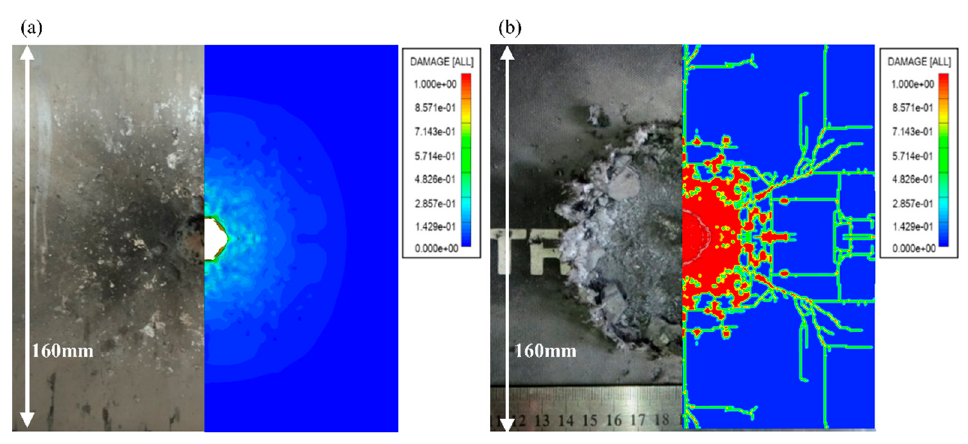
Figure 12. The experiment and simulation damage contours of the rear plate (( a ) Configuration A-1; ( b ) Configuration B-1).